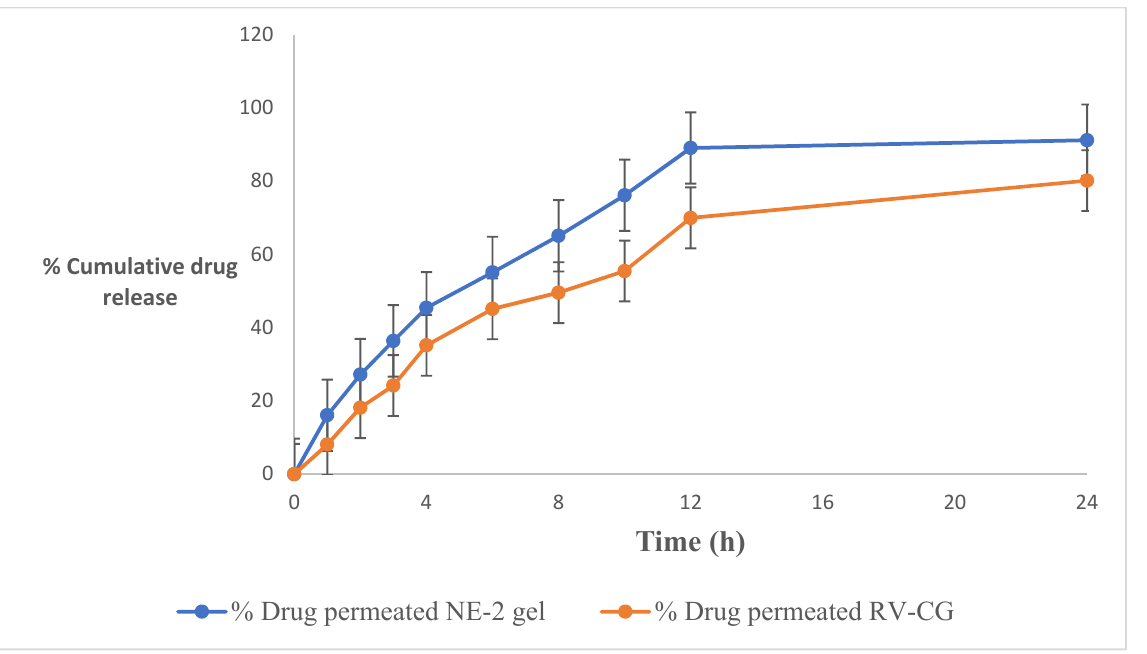
Figure 4. Percentage of cumulative drug release of the resveratrol-loaded NE2 gel vs. conventional gel (CG) formulation. The average value ± SD (n = 3) is represented by each cross bar. NE: nanoemulsion; CG: conventional gel.